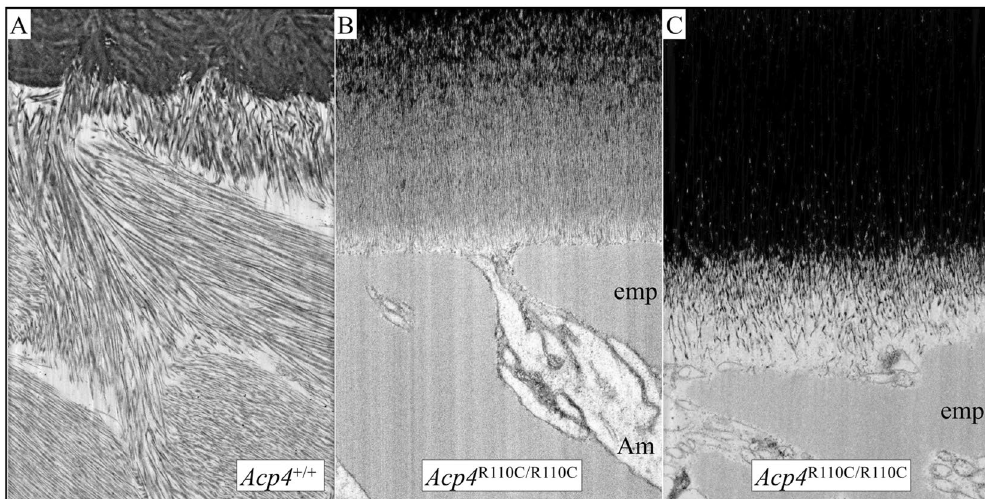
Figure 10. FIB-bSEM of 7-week Acp4 +/+ and Acp4 R110C/R110C Mandibular Incisors (continued). The images show enamel formed later during the secretory stage in ( A ) Acp4 +/+ and ( B , C ) Acp4 R110C/R110C incisors (all at 20,000×). At the position where Acp4 +/+ ameloblasts have formed an enamel layer that is ~ 30 µm in thickness (7-wk incisor Level 1.5; DEJ area shown in A ), the Acp4 R110C/R110C ameloblasts have only deposited an aplastic enamel layer about 6 µm thick on the DEJ ( B ). Abundant enamel proteins have also accumulated on top of the mineralized portion, and the distal ends of ameloblasts retain only finger-like point contacts/attachment with the mineralized surface ( B ). By roughly the midpoint of the secretory stage (Level 2, C ), the enamel organ in Acp4 R110C/R110C mice degenerates into a disorganized mass of cells. The precise location of the DEJ becomes indistinct due to increased mineralization of the deeper parts of the aplastic enamel layer, which is now about 11 µm in thickness. Am, ameloblasts; emp, enamel matrix proteins.